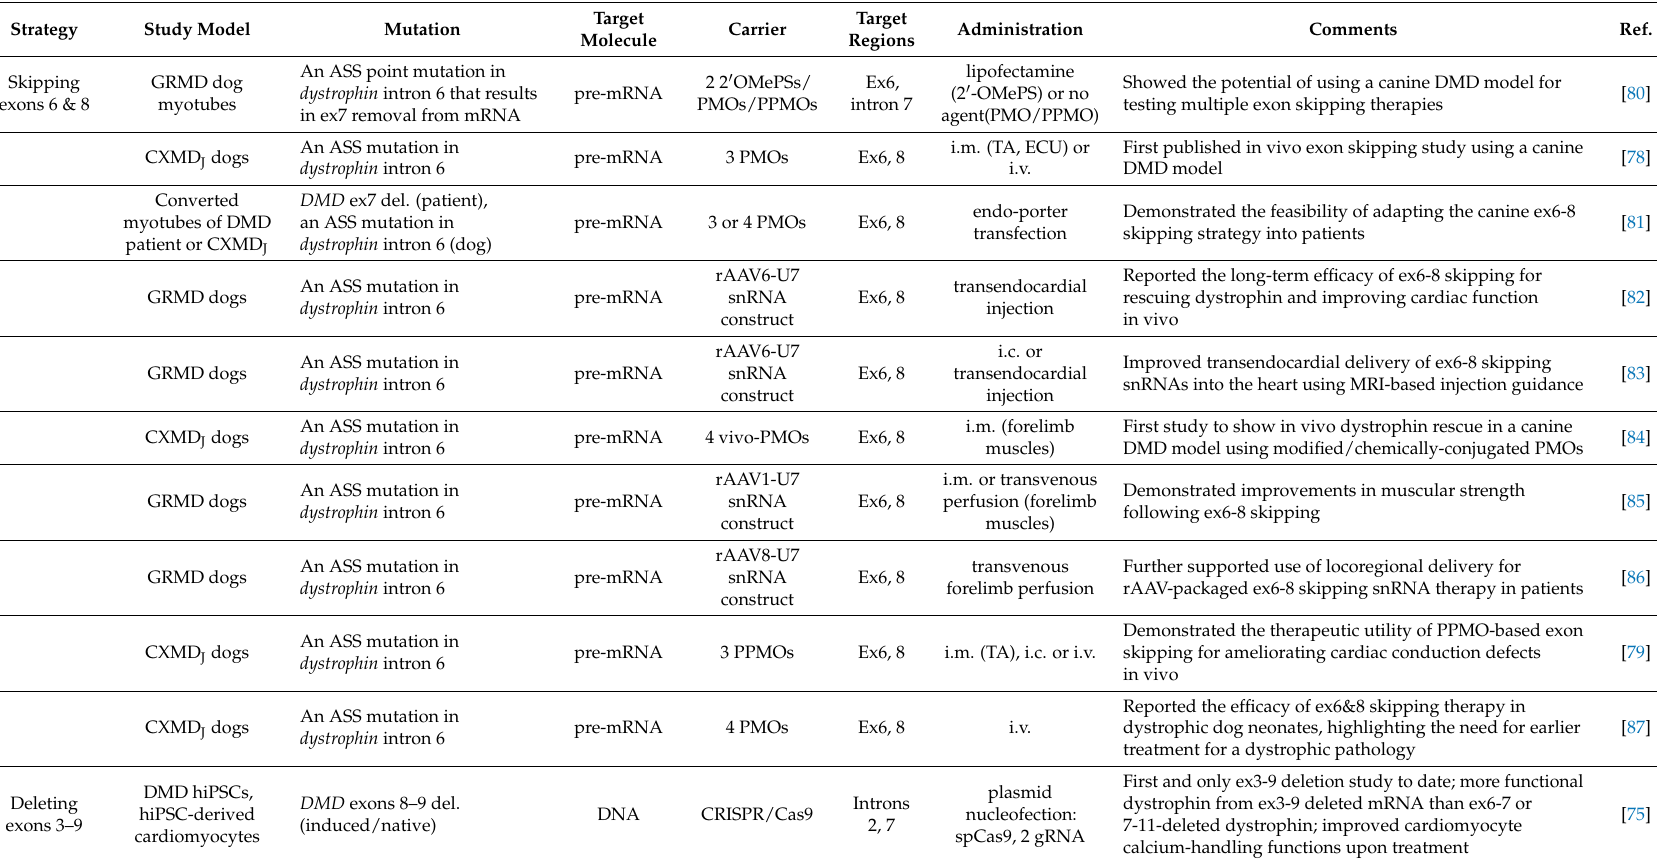
Table 2. Pre-clinical studies with skipping exons 6 and 8 and deleting exons 3–9 in the proximal hot